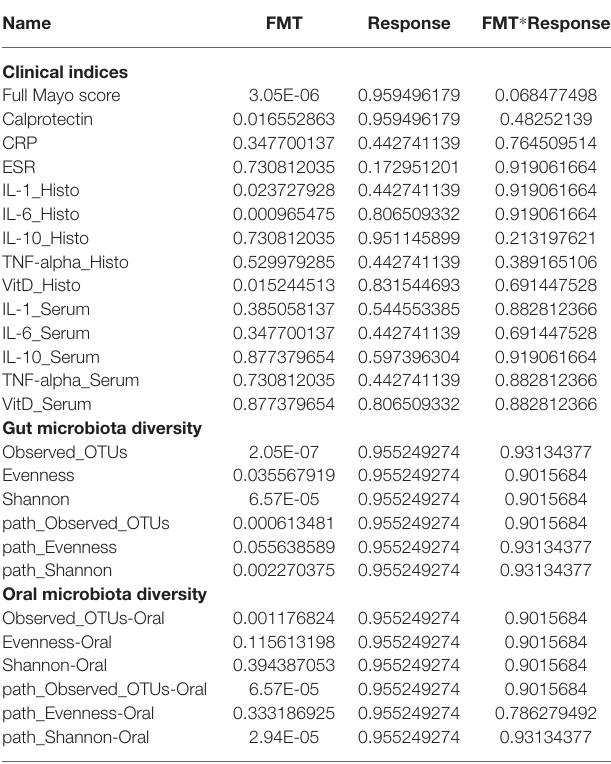
TABLE 2 | Corrected p values of two-way ANOVA